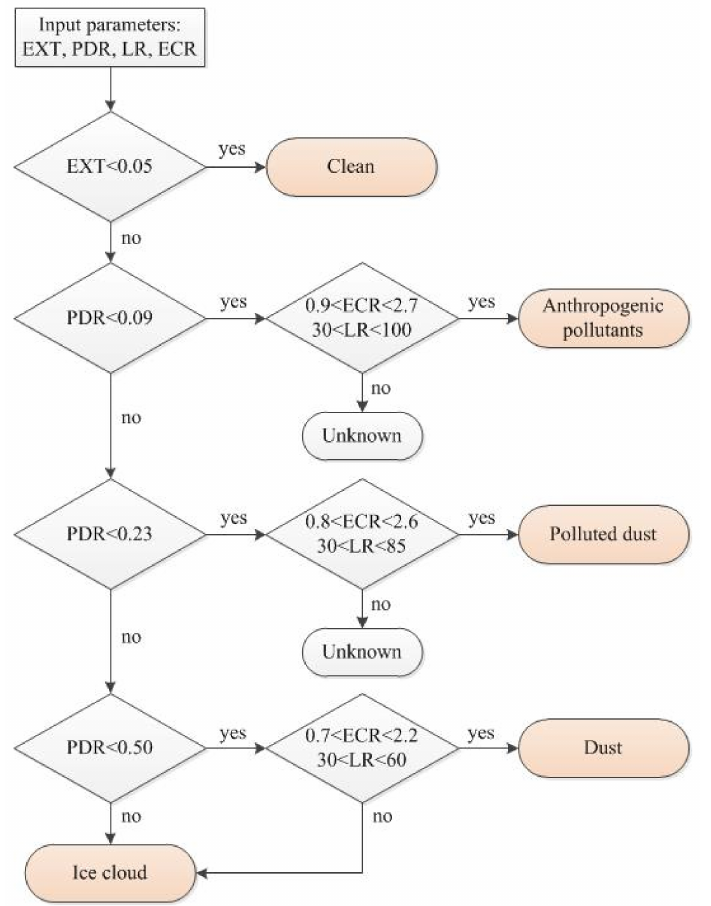
Figure 6. Flowchart of aerosol type classification in BTH region according to PDR 532 , LR 355 , and ECR 355/532 measured by MRL.